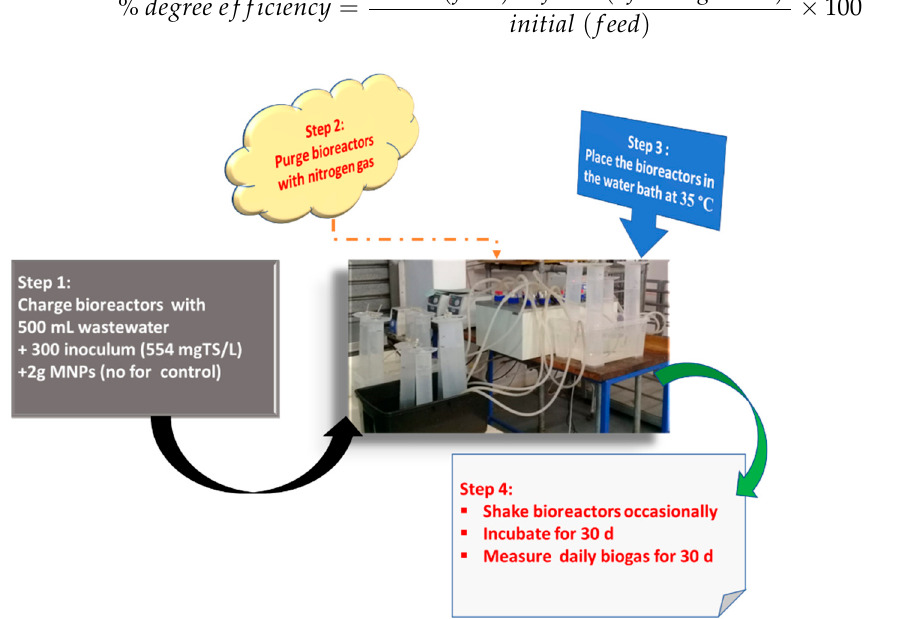
Figure 6. Schematic diagram of experimental procedure.